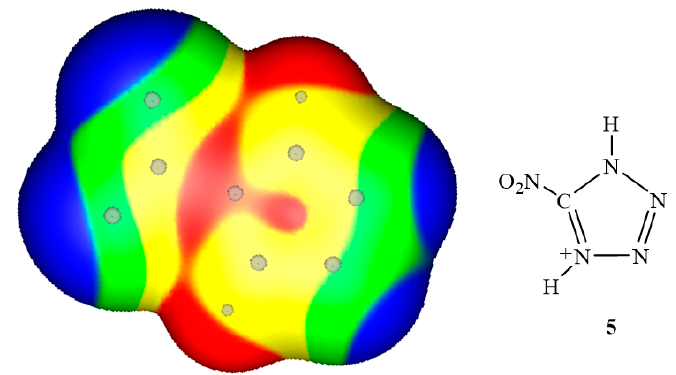
Figure 6. Computed electrostatic potential on 0.001 au cationic surface of 5-nitrotetrazolium cation ( 5 ). Color ranges, in kcal/mol, are: red, greater than 150; yellow, between 150 and 120; green, between 120 and 90; blue, less than 90. Circles shown positions of atoms; NO 2 group is on the left. Most positive potentials are 174 kcal/mol by hydrogens.